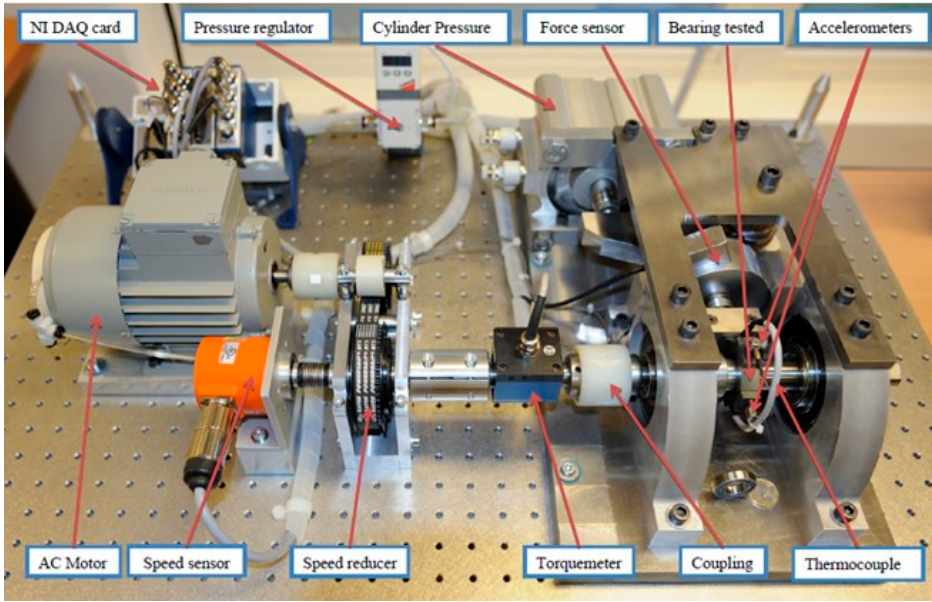
Figure 4. The PRONOSTIA platform.